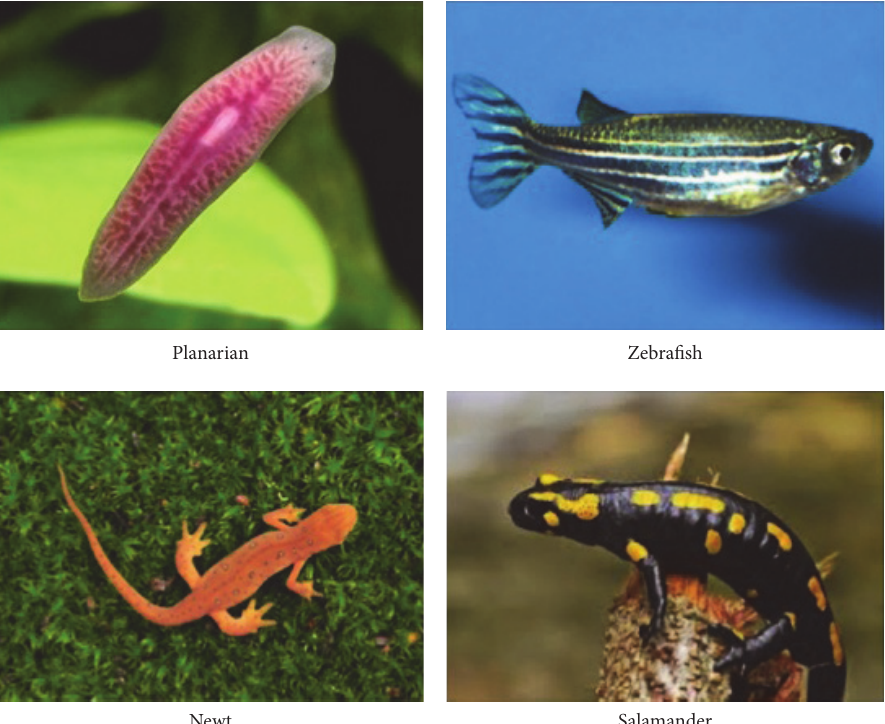
Figure 3: Planarians, zebrafish, newts, and salamanders have the capacity to self-regenerate damaged appendages and critical